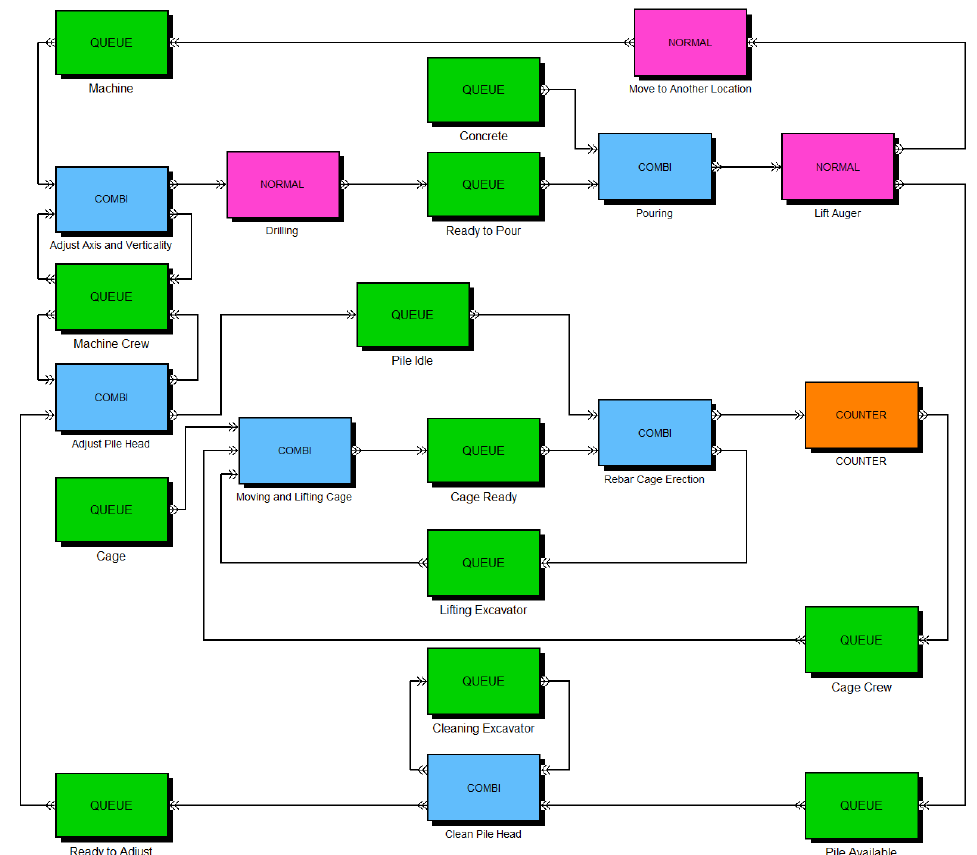
Figure 2. CFA pile installation simulation model.